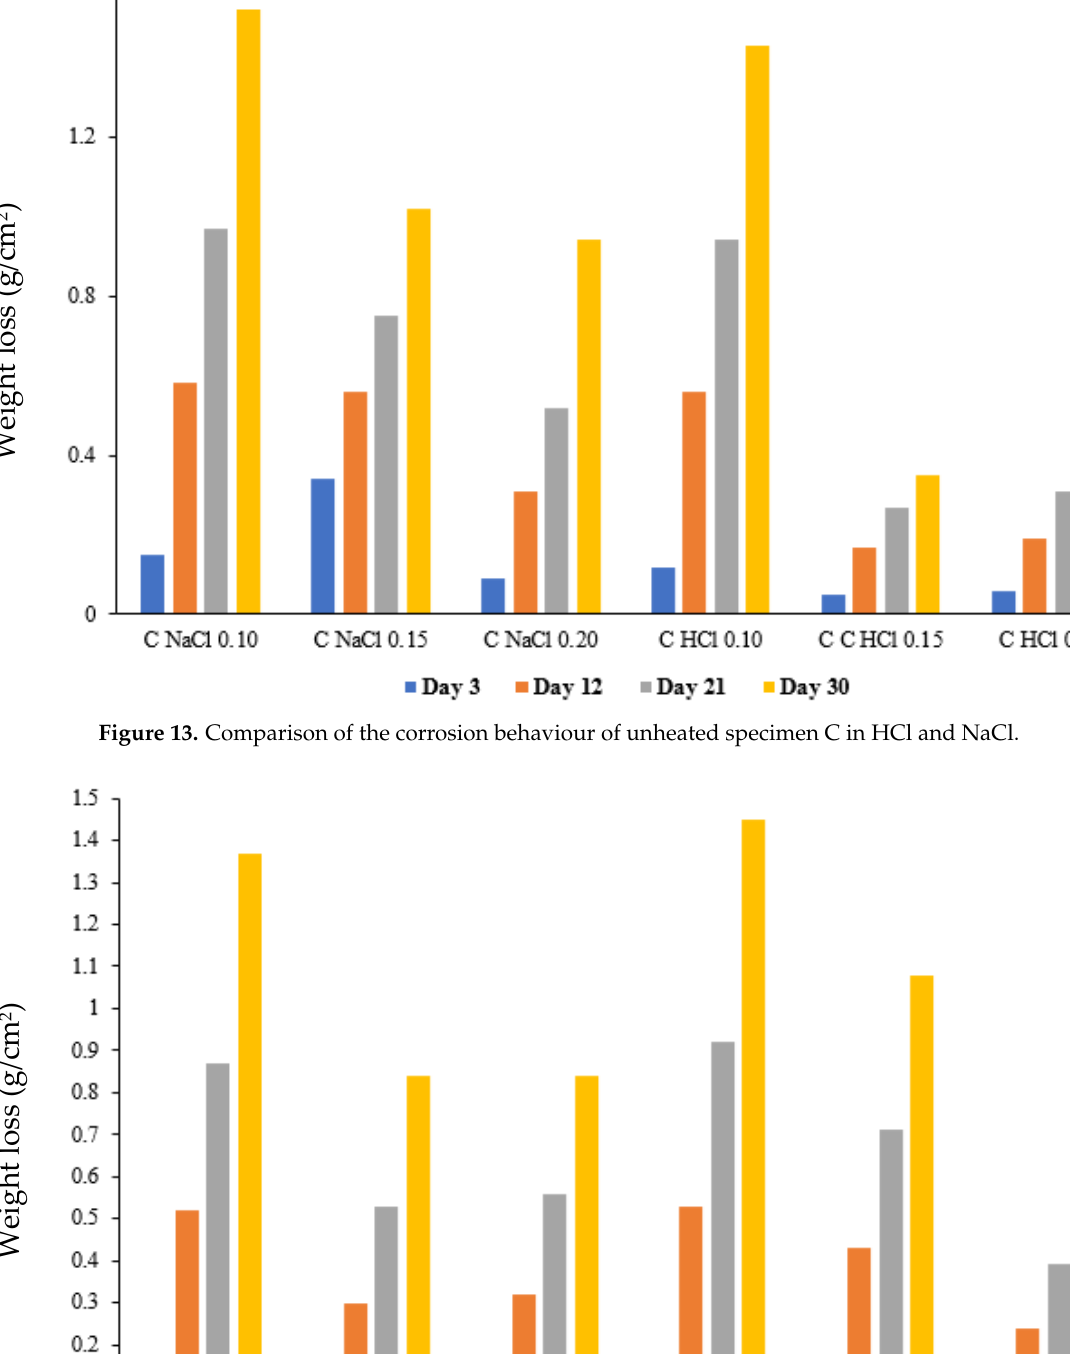
The heat treatment process results in the recrystallisation of the Aluminium alloys,